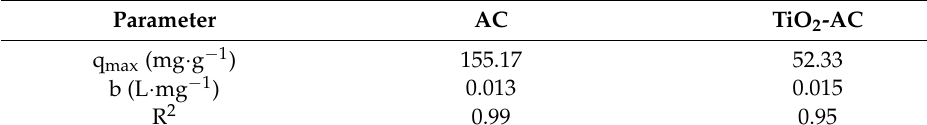
Table 3. Parameters calculated for Langmuir isotherm model.